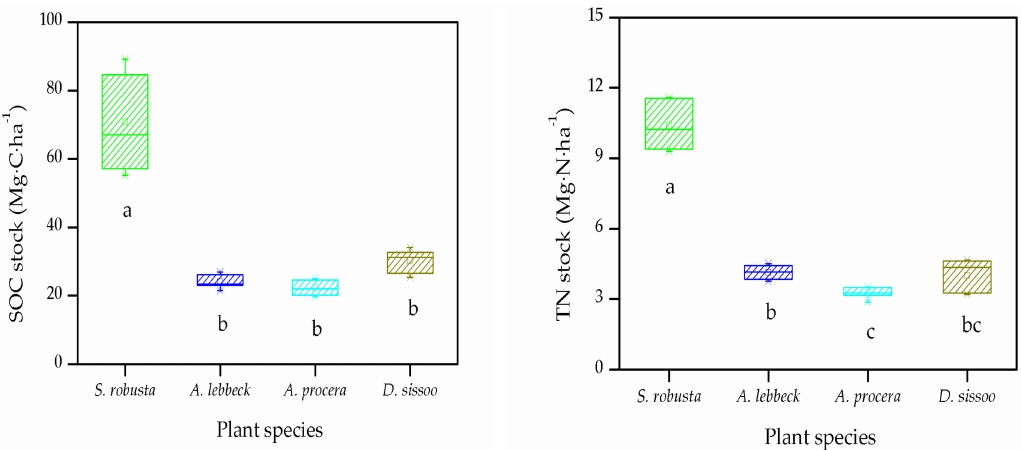
Figure 3. Variations in soil organic carbon (SOC) and total nitrogen (TN) stock under di ff erent plant species in the natural forest ( Shorea robusta ) and a ff orested trees ( Albizia lebbeck, Albizia procera, and Dalbergia sissoo ). (Box represents the interquartile range of the data set, and the upper and lower limits of the box show the first quartile and third quartile of the data. Middle line and dot show median and mean value, respectively. Whiskers represent the upper and lower range of the data). Di ff erent letters (a, b, c) indicate a significant di ff erence at p < 0.05, where “a” indicates a significantly higher value, and “b” indicates significantly lower values for the SOC stock. The letter “a” indicates significantly higher values, and “c” indicates significantly lower values for TN stock, whereas the letter “b” denotes values which are significantly lower than “a” and significantly higher than “c”. Letters “bc” indicate insignificantly di ff erent values from “b” and “c”.